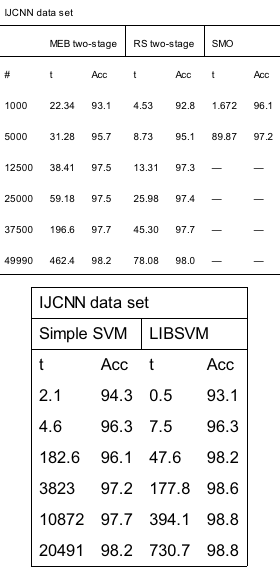
RNA sequence data set